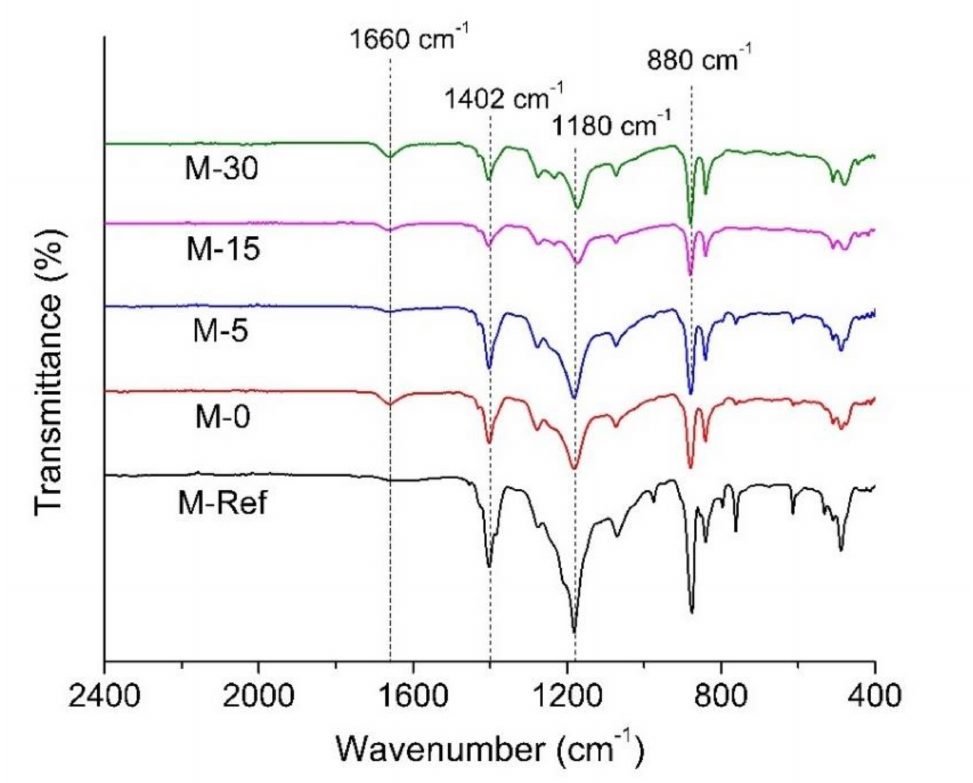
Figure 6. FTIR spectra of the resulting